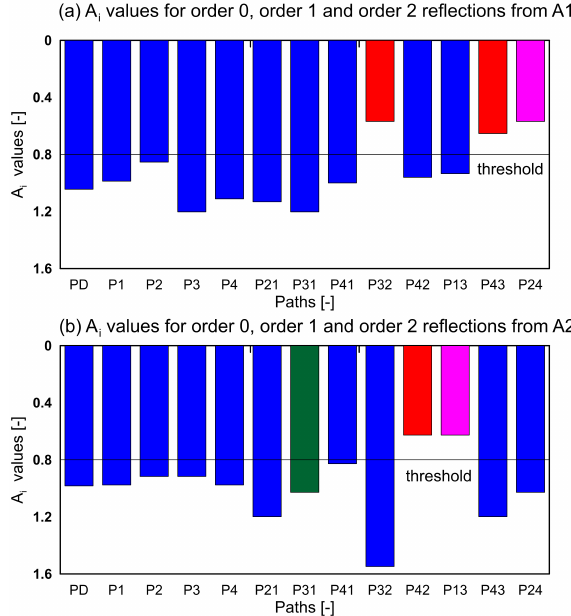
Figure 12. A i ratio for all identified edge reflection paths for both AS